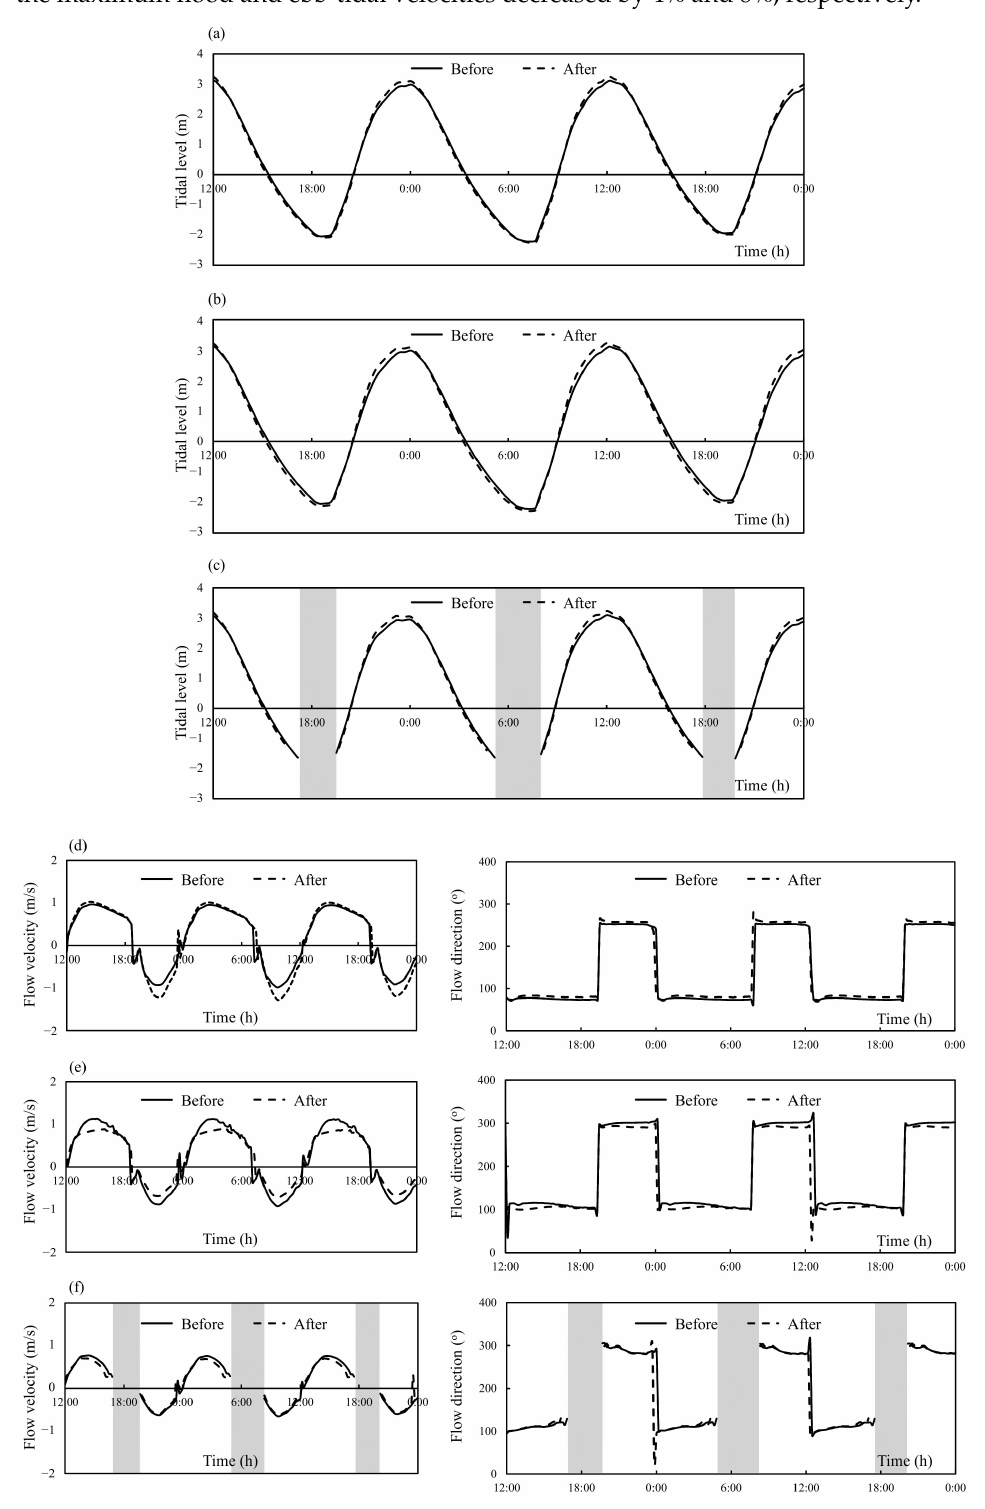
Figure 7. Comparison of the tidal levels at ( a ) P1, ( b ) P2, and ( c ) P3, and the flow velocities and directions at ( d ) P1, ( e ) P2, and ( f ) P3 before and after the construction of the NRTG, during the spring tide. The shading represents the exposure period of the intertidal